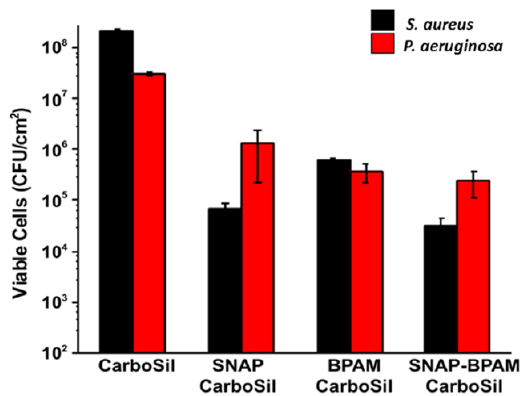
Figure 5. Comparison of the inhibition of viable colony forming units (CFU cm-2) of S. aureus and P. aeruginosa on the surface Carbosil of S -nitroso- N acetylpenicillamine (SNAP) films, benzophenone based quaternary ammonium molecules (BPAM) films and SNAP-BPAM films. Reproduced with permission from reference [76]. Copyright 2017 RSC.